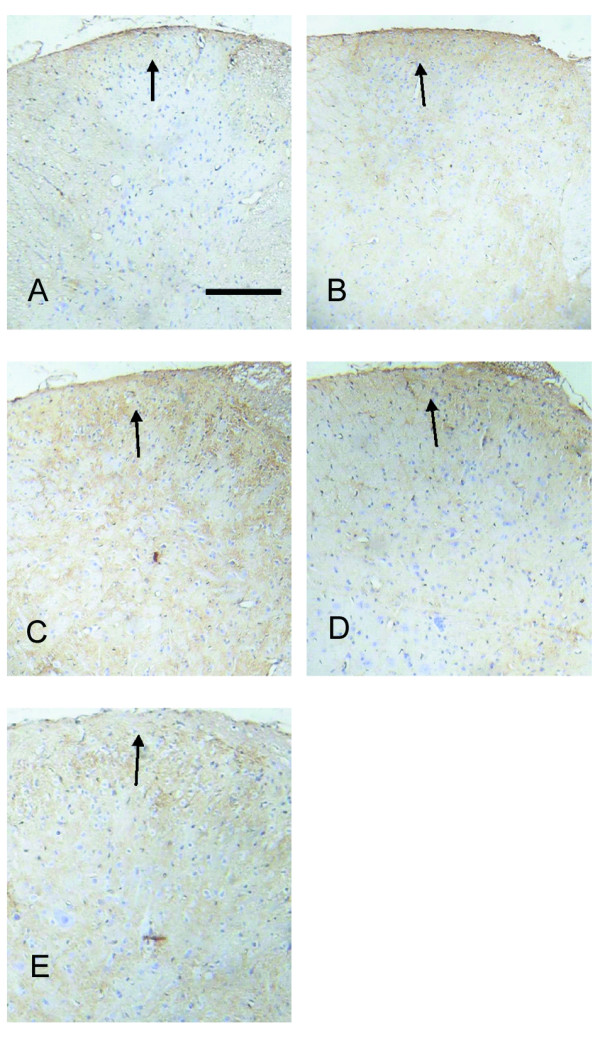
Typical photomicrographs representing tyrosine phosphorylation of NR2B immunoreactive neurons in the superficial dorsal horn. The L4-L5 spinal cords for analysis were collected at 48 h after the surgery. In preparations of control group, hardly any tyrosine phosphorylation of NR2B immunoreactive neurons was found in the dorsal horn region (A). In preparations of rats with incision receiving saline or ketamine, moderate tyrosine phosphorylation of NR2B immunoreactive neurons was obtained in the superficial dorsal horn (Laminae I-II) at the L4-L5 spinal cord, ipsilateral to the incision (B and C). The number of tyrosine phosphorylation of NR2B immunoreactive neurons were drastically upregulated in rats receiving infusion of remifentanil (D), which was remarkably inhibited by pretreatment with ketamine (E). Magnification: × 100. Scale bar = 100 μm.